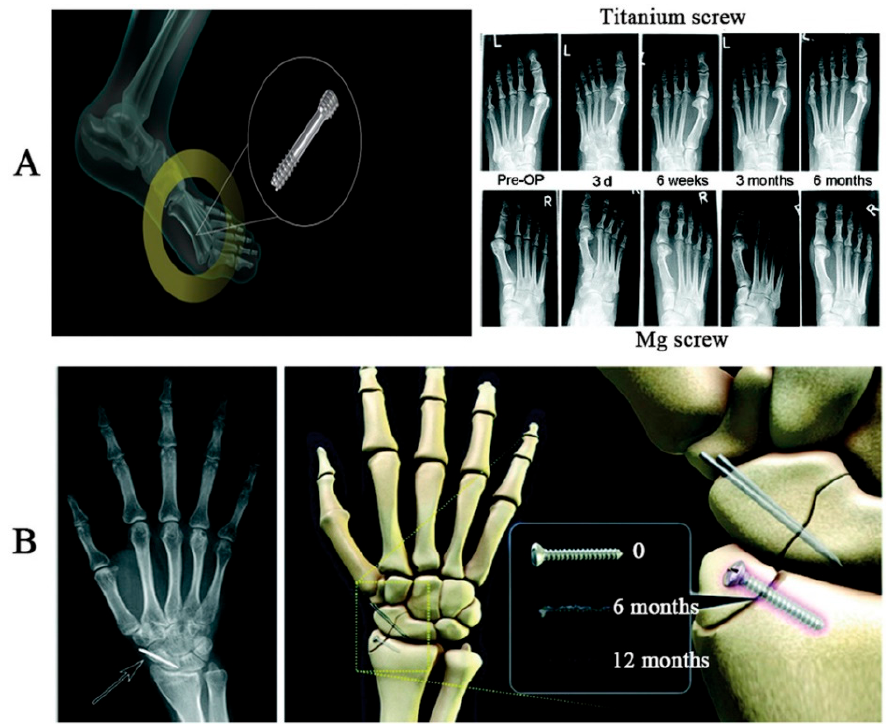
Figure 4. Examples of magnesium applications in orthopedics. ( A ) Use of MAGNEZIX ® MgYREZr alloy bioabsorbable compression screw to treat hallux valgus fracture in 13 patients. Reproduced